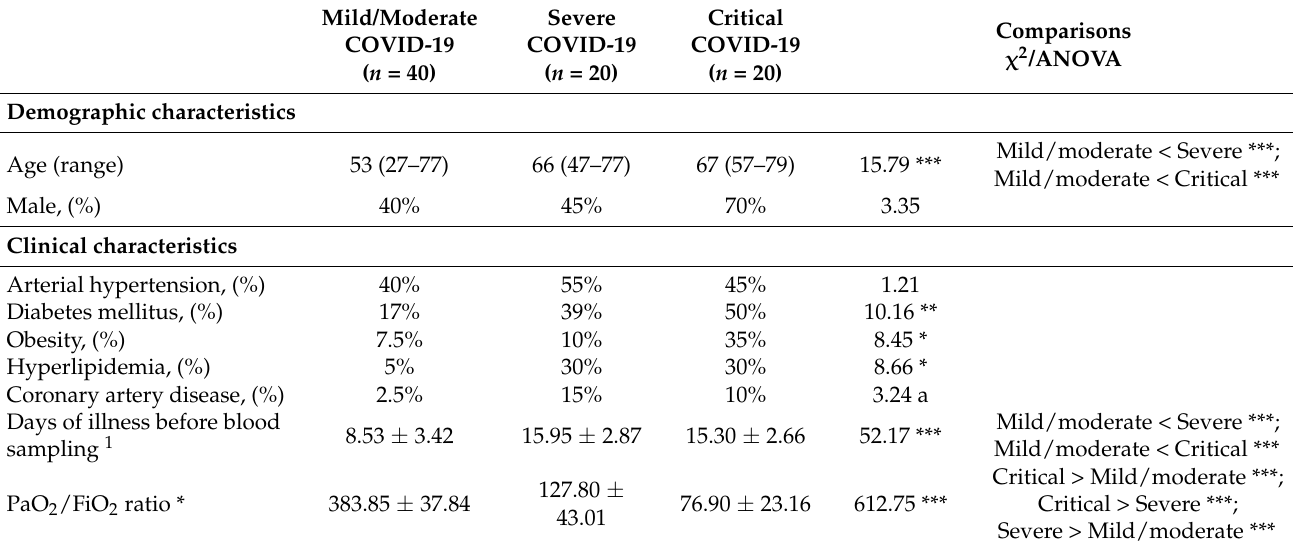
Table 1. Patient demographic and clinical data according to COVID-19 disease severity.